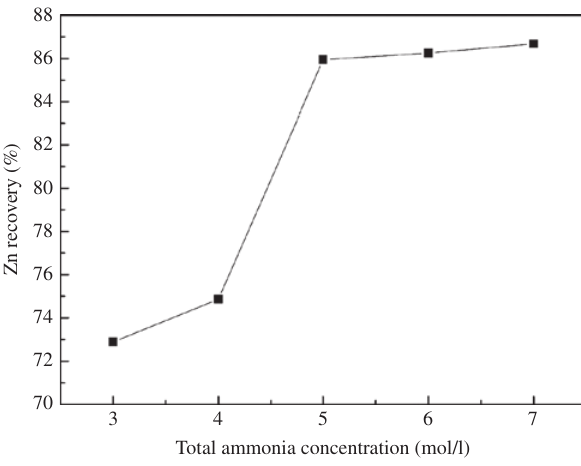
Figure 6: Effect of different total ammonia concentrations on leach- ing rate of zinc.